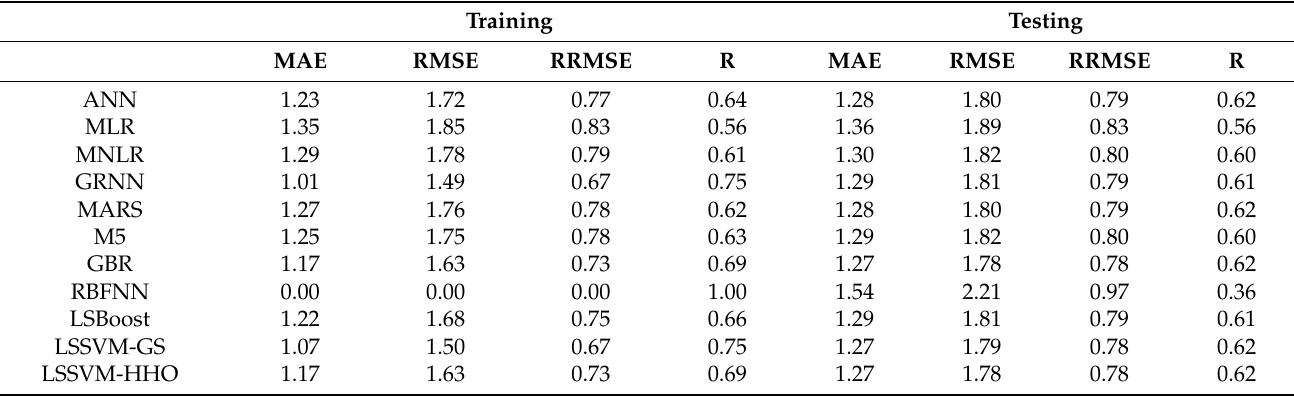
Table A10. Results of modeling WS with the base algorithms at the Nehbandan